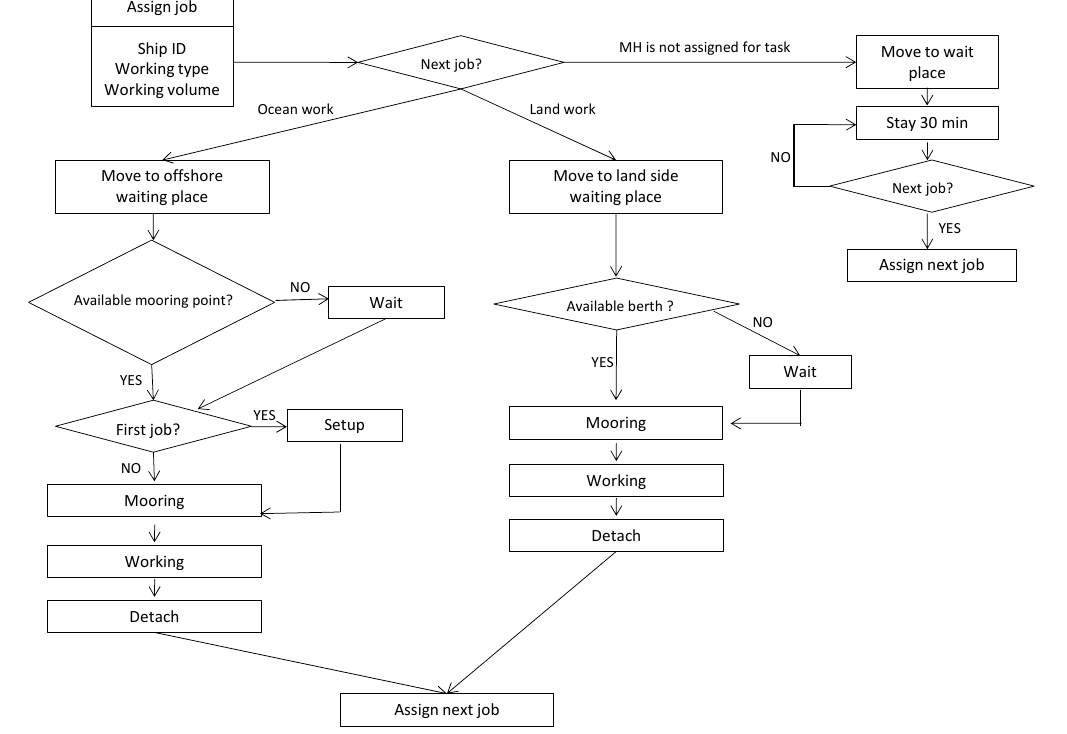
Figure 2. Overall work process of the MH.